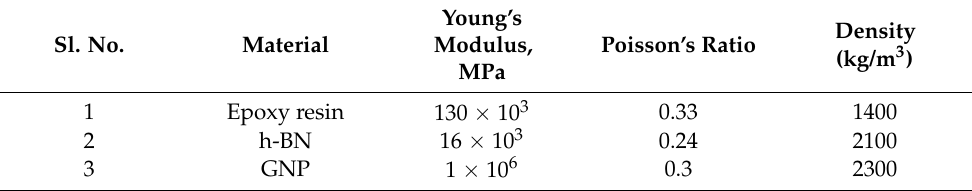
Table 11. Material properties for h-BN and